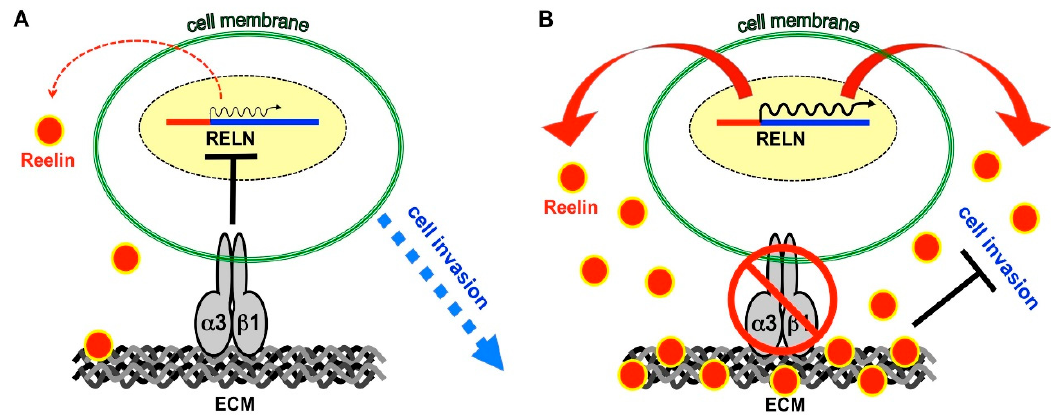
Figure 9. Regulation of the RELN gene by integrin α 3 β 1 modulates breast cancer cell invasion. ( A ) α 3 β 1 represses RELN gene expression by tumor cells, minimizing the production and secretion of Reelin protein (red circles) and supporting cell invasion. ( B ) Suppression or blocking of α 3 β 1 relieves repression of the RELN gene, leading to enhanced secretion of Reelin protein that inhibits cell invasion. ECM, extracellular matrix.